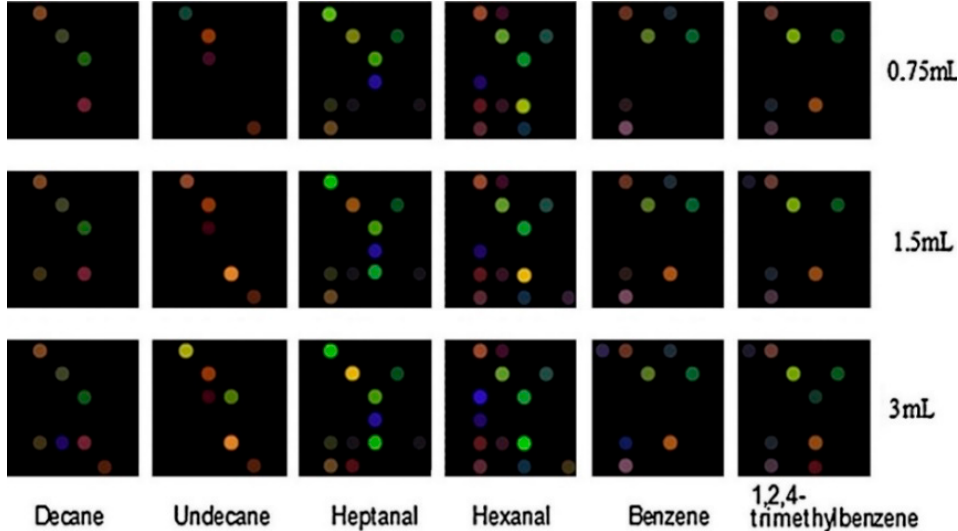
Figure 13. Detailed color difference maps of six VOCs at three volumes (0.75, 1.5, and 3 mL saturated vapor, respectively) saturated analyte vapor at 20 °C, acquired by metalloporphyrin-AuNRs and dyes-based optical chemical sensor. Metalloporphyrin-AuNRs exhibited increased responsiveness and high sensitivity and selectivity due to their high affinity. Reprinted with permission from